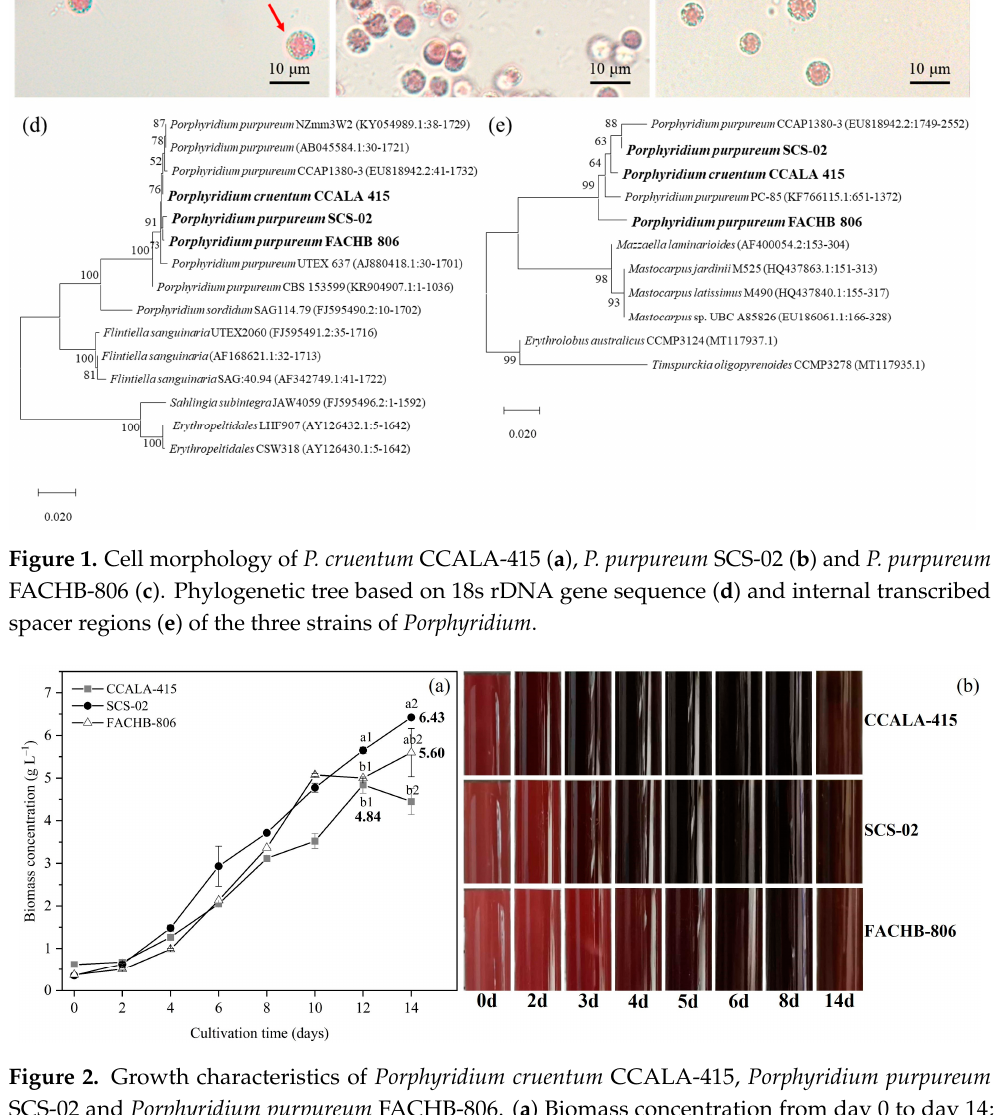
Figure 1. Cell morphology of P . cruentum CCALA-415 ( a ), P . purpureum SCS-02 ( b ) and P . purpureum FACHB-806 ( c ). Phylogenetic tree based on 18s rDNA gene sequence ( d ) and internal transcribed spacer regions ( e ) of the three strains of Porphyridium.